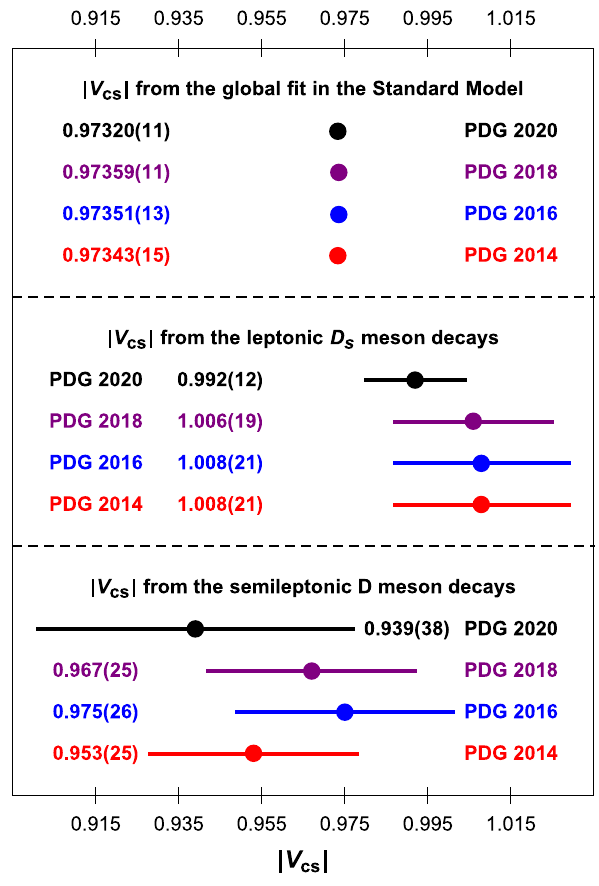
Fig. 5 The values of the CKM element | V cs | from